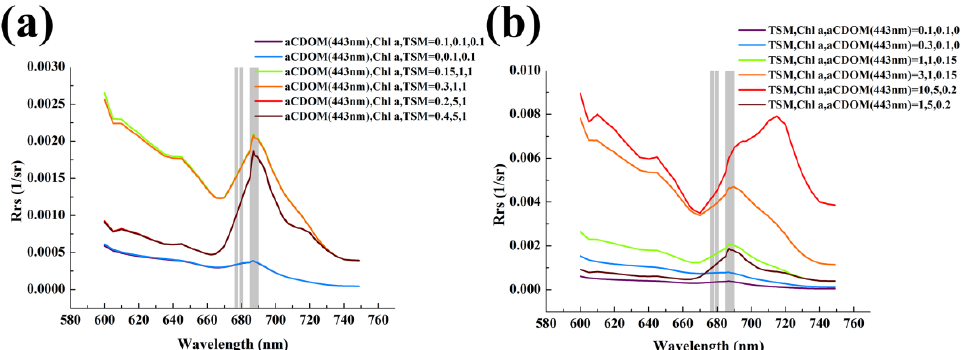
Figure 4. Effects of ( a ) aCDOM (443 nm) and ( b ) TSM changes in different water bodies. The three gray histograms denote the positions of the 678, 680, and 685–690 nm bands, respectively.